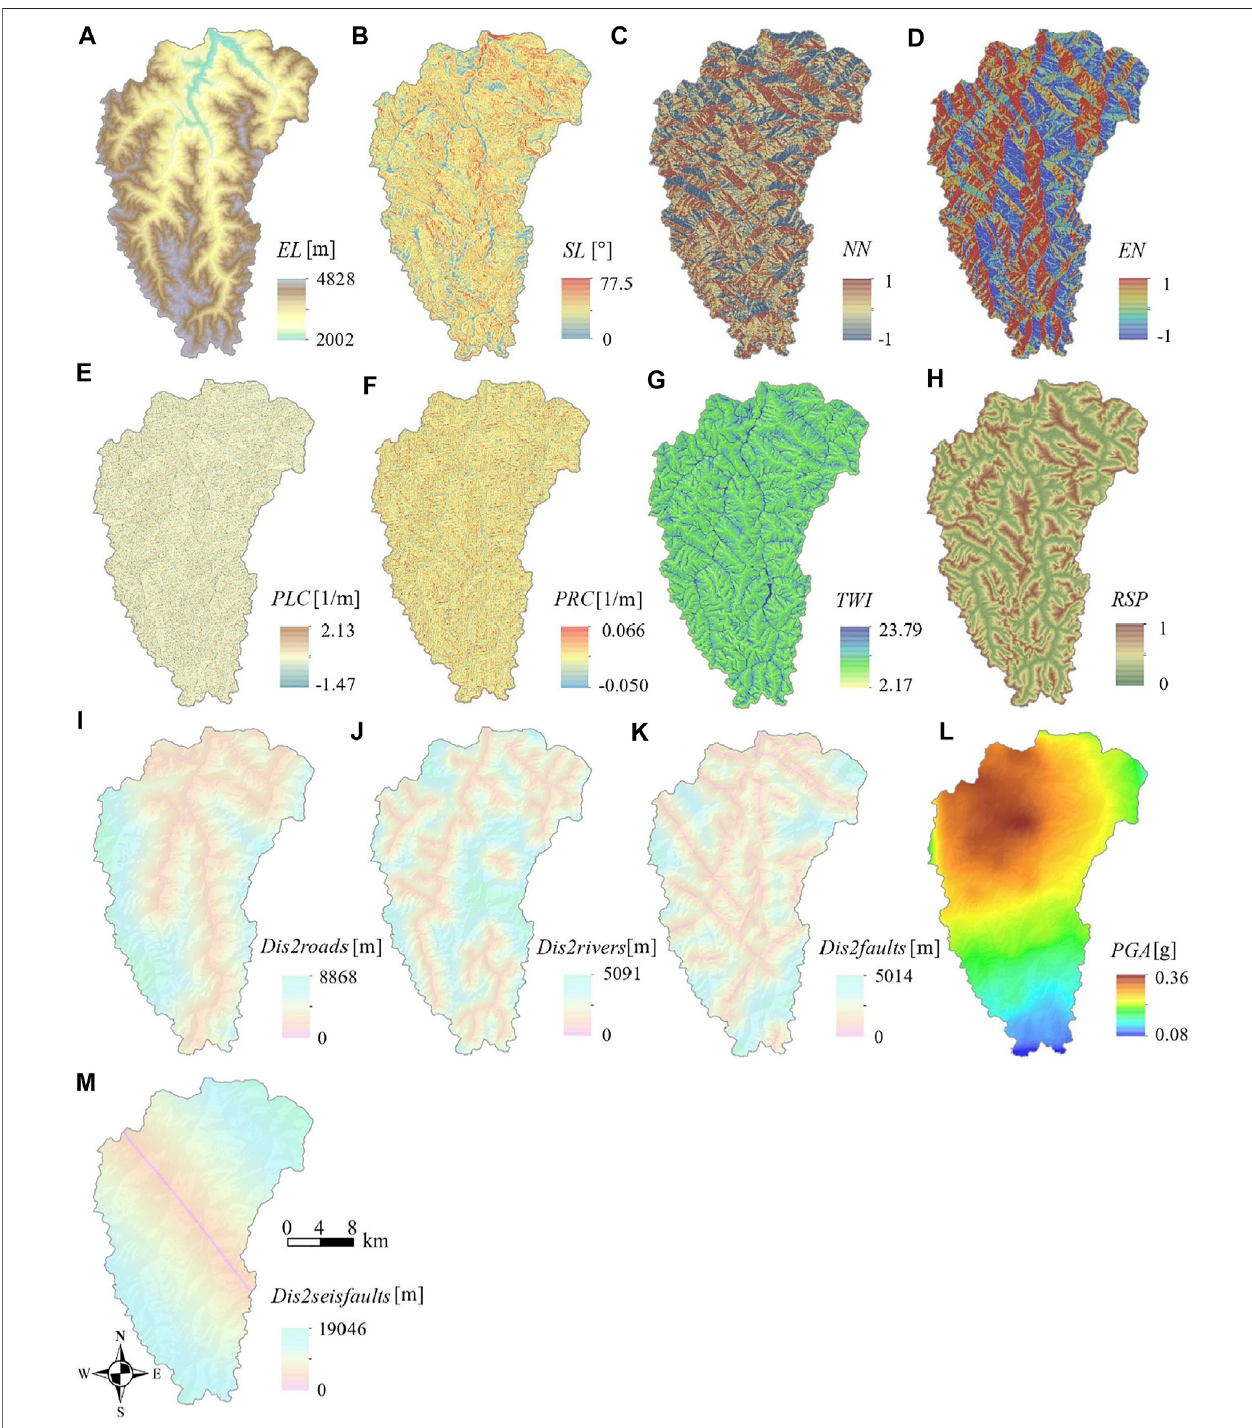
FIGURE 5 | Spatial distribution of conditioning factor raster layers in the grid used for modeling phases in the study area: (A) Elevation, (B) Slope angle, (C) Northness, (D) Eastness, (E) Plan curvature, (F) Pro fi le curvature, (G) TWI, (H) RSP, (I) Distance to roads, (J) Distance to rivers, (K) Distance to faults, (L) PGA, and (M) Distance to seismogenic